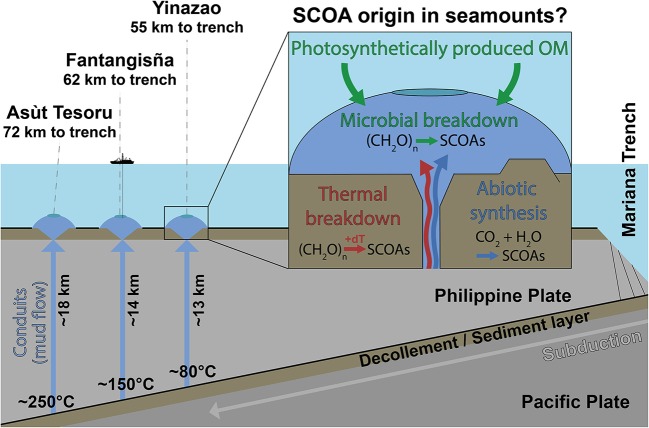
Schematic dissection of the Yinazao, Fantangisña, and Asùt Tesoru mud volcanoes in relation to the Mariana Trench, which is formed by subduction of the Pacific Plate under the Philippine Plate. The Pacific Plate and its sediment cover are exposed to increasing temperatures as they are subducted. The Yinazao, Fantangisña, and Asùt Tesoru mud volcanoes are shown in blue due to the distinct blue color of the dominant lithology, upwelling serpentinite mud. Investigating how SCOA compositions, and origins (microbial, thermogenic, abiotic) change both horizonally and vertically between and within these mud volcanoes provides insights into the controls on carbon transformation reactions in the deep subseafloor.